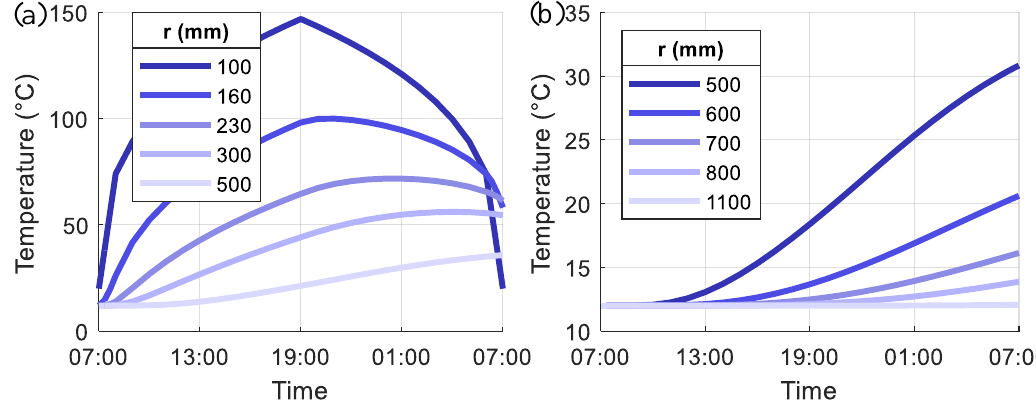
Figure 8. Temperature change in the first loading cycle: ( a ) concrete; ( b ) soil.